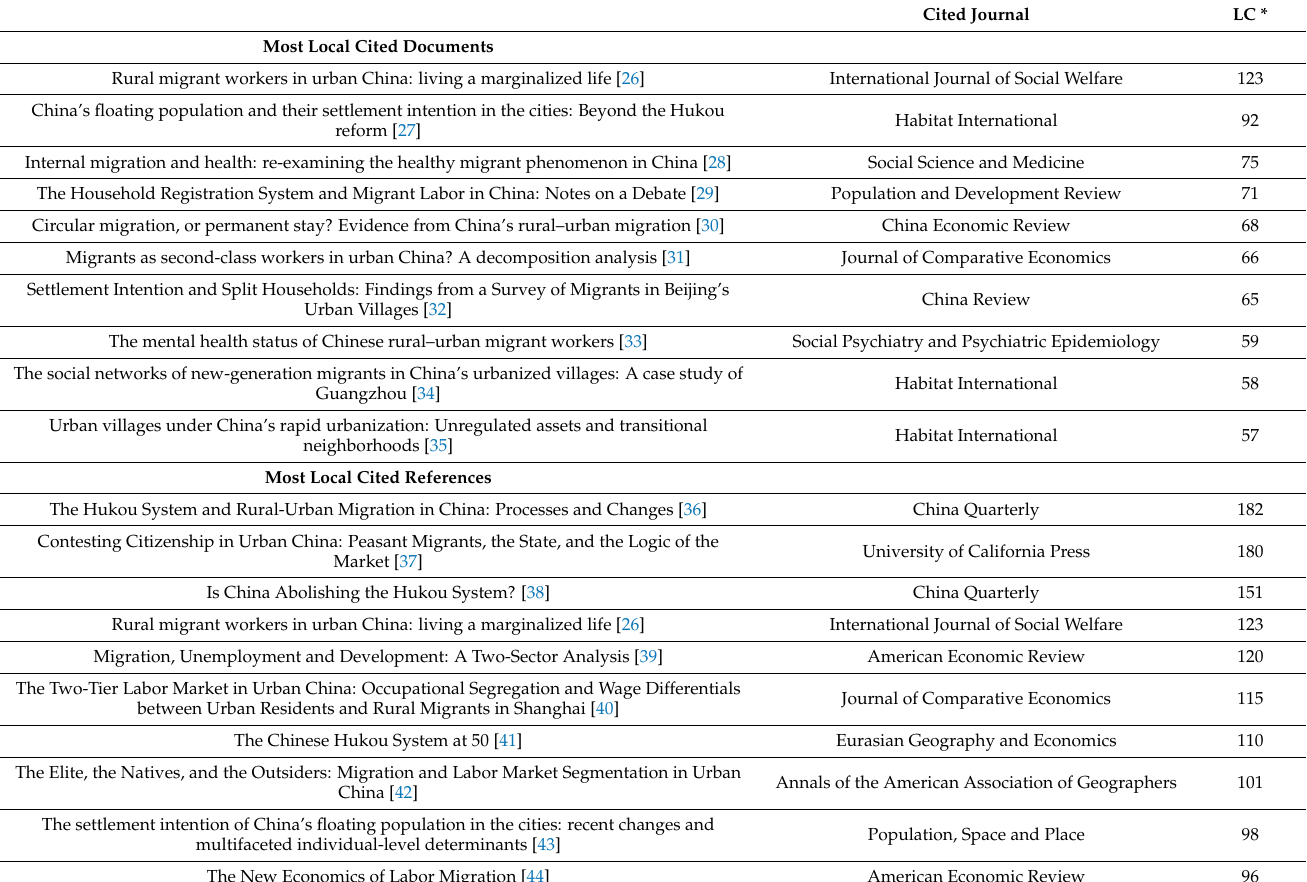
Table 5. Top 10 locally cited documents and references on the topic of rural-to-urban migrants (1 January 2004–3 June